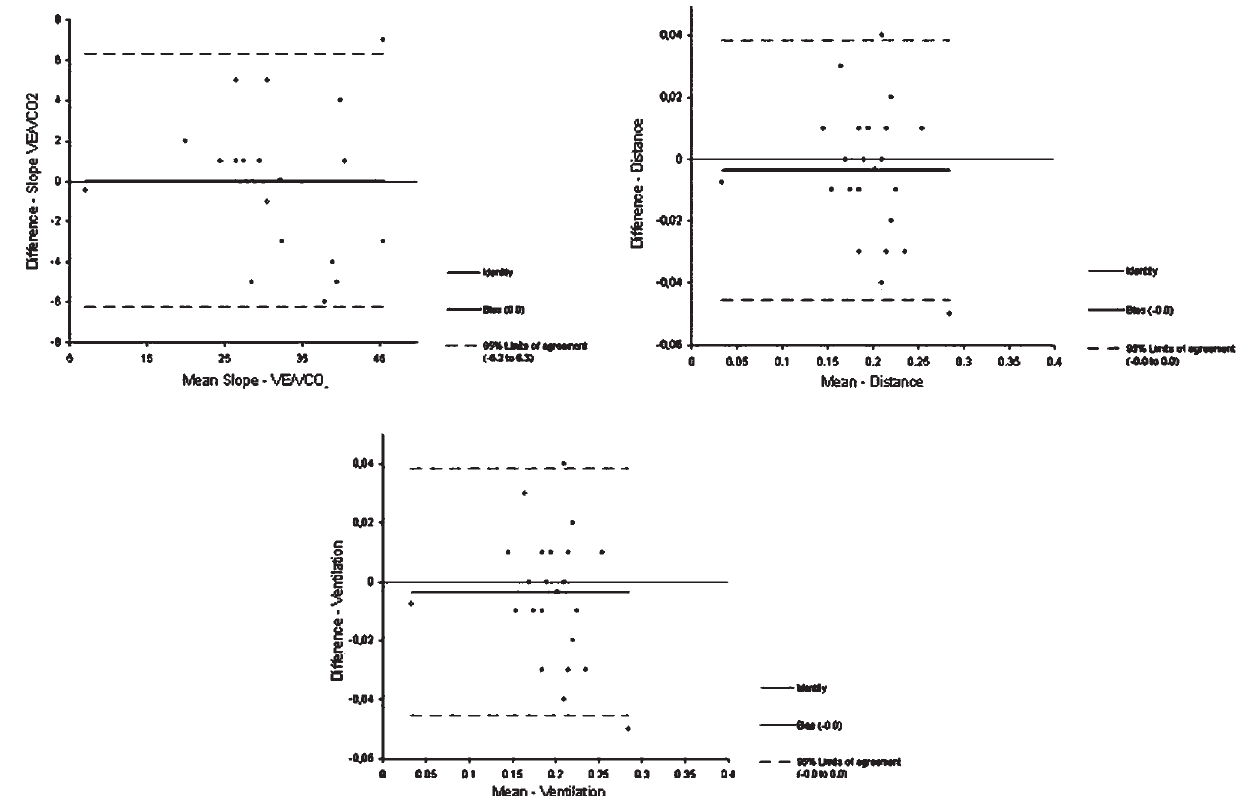
Figure 3 - Bland & Altman plots between test-1 and test-2 for slope VE/VCO2, distance and